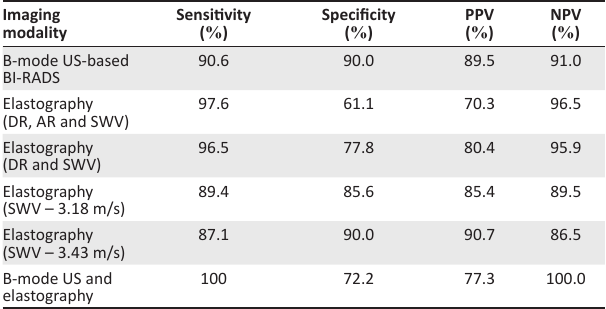
TABLE 5: Diagnostic performance of various imaging modalities. TABLE 4: Comparison of ultrasonography and elastography parameters in the